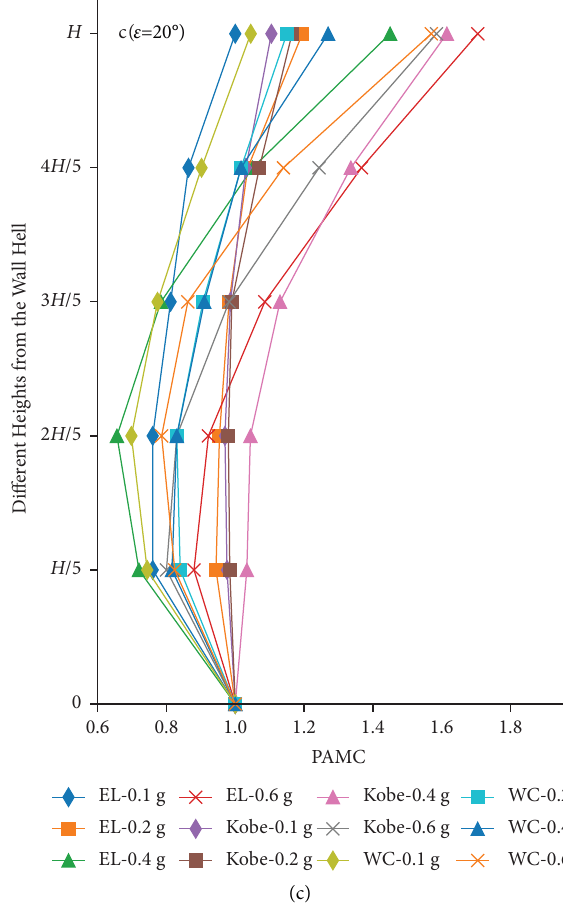
Figure 6: PAMC along wall height. (a) Reclined wall. (b) Vertical wall. (c) Inclined